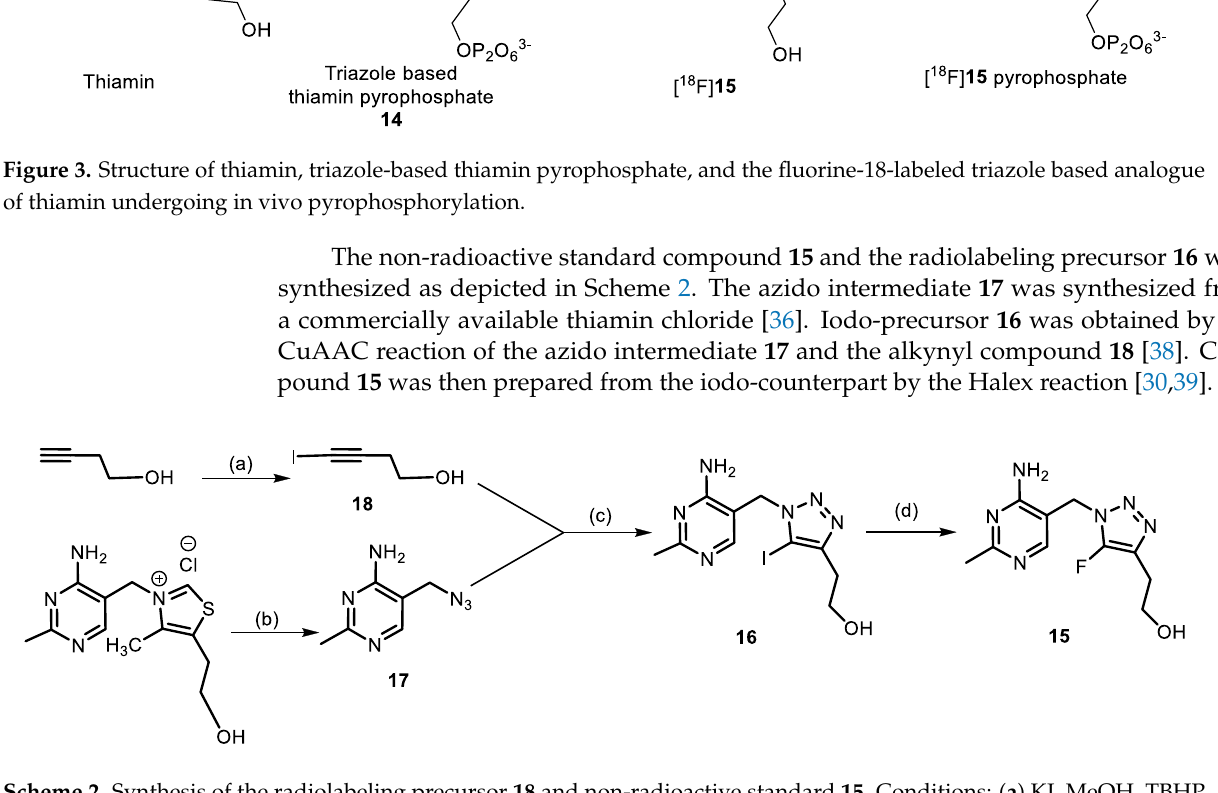
Figure 2. Substrate scope study. Reaction condition: precursor (5 mg), [ 18 F]HF in target water (370 – 740 MBq), K 2 CO 3 (60 µg, 0.43 µmol), DMSO (0.3 mL), 150 °C MW, 20 min. RCC was determined by analytical HPLC and the identity of the product was confirmed by co-injection with the standard compounds. HPLC condition: Phenomenex Luna C18 (2) col-